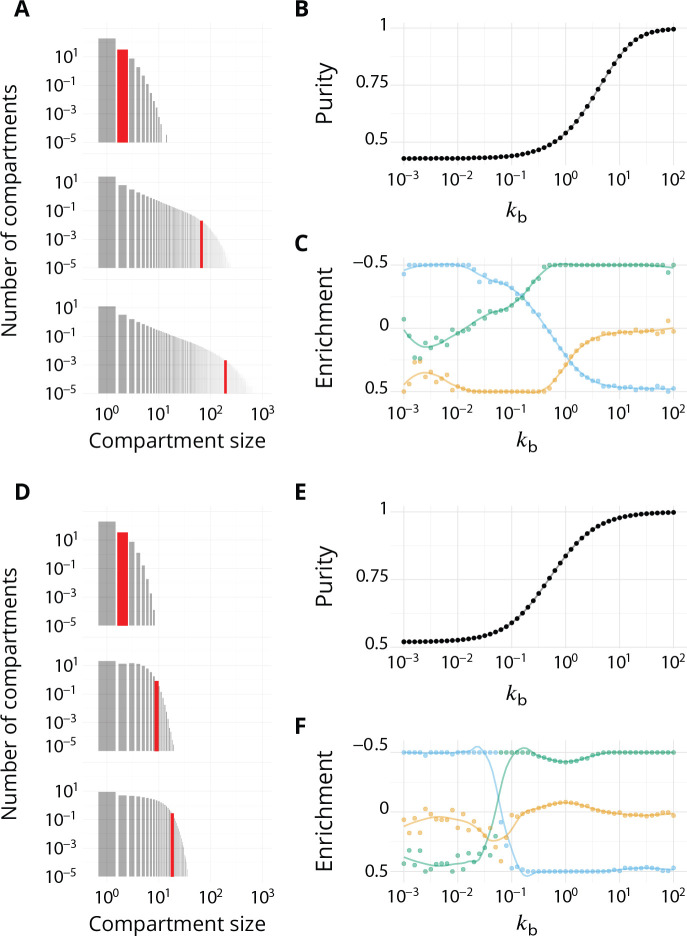
Impact of different budding and fusion kernels on the system's organisation and vesicular transport.Related to Figures 2–4 - main text. km=α=1. (A–C) Linear budding scheme. (D–F) Inter-compartment fusion is prohibited. (A and D) Size distribution of compartment for kb equals 102 (top), 1 (middle) and 102 (bottom). (B and E) Steady-state purity as a function of kb. (C and F) Enrichments in cis (blue), medial (orange) and trans-species (green) during vesicular transport (details of computations of this enrichment presented in Appendix 2) as a function of kb.